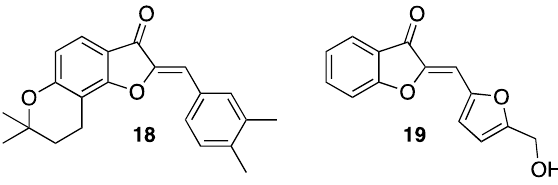
Figure 6. Representative examples of synthetic anti-inflammatory aurones.